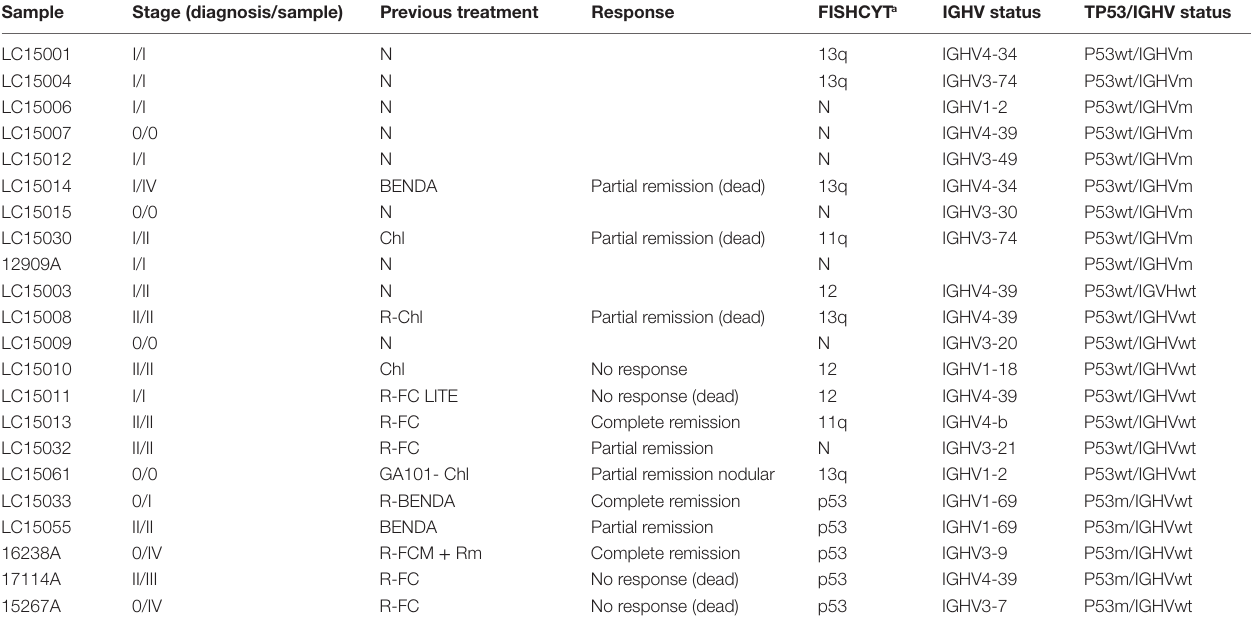
TaBle 5 | characteristics of cll patients used in the study of susceptibility in relation to prognosis.